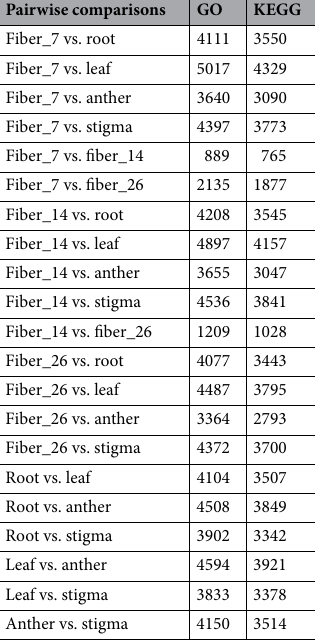
Table 2. Summary of annotated genes in each database for the pairwise